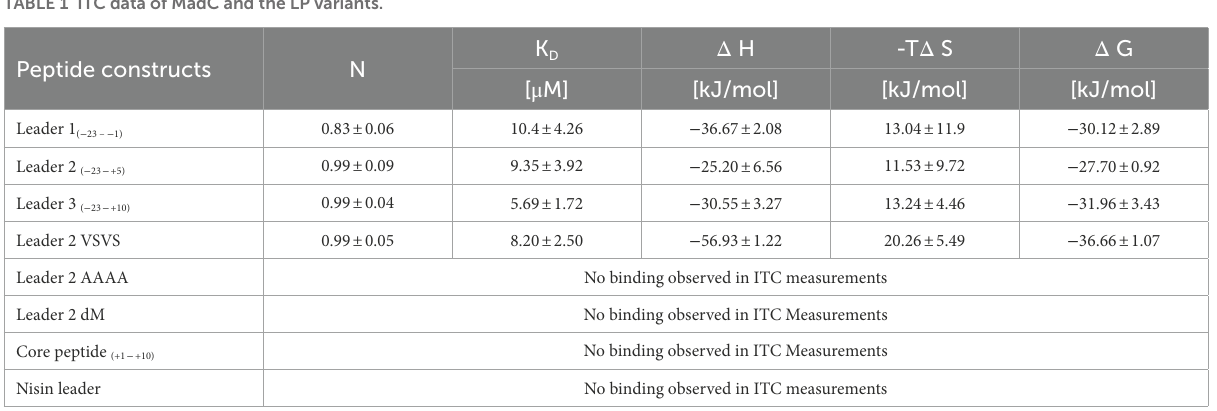
TABLE 1 ITC data of MadC and the LP